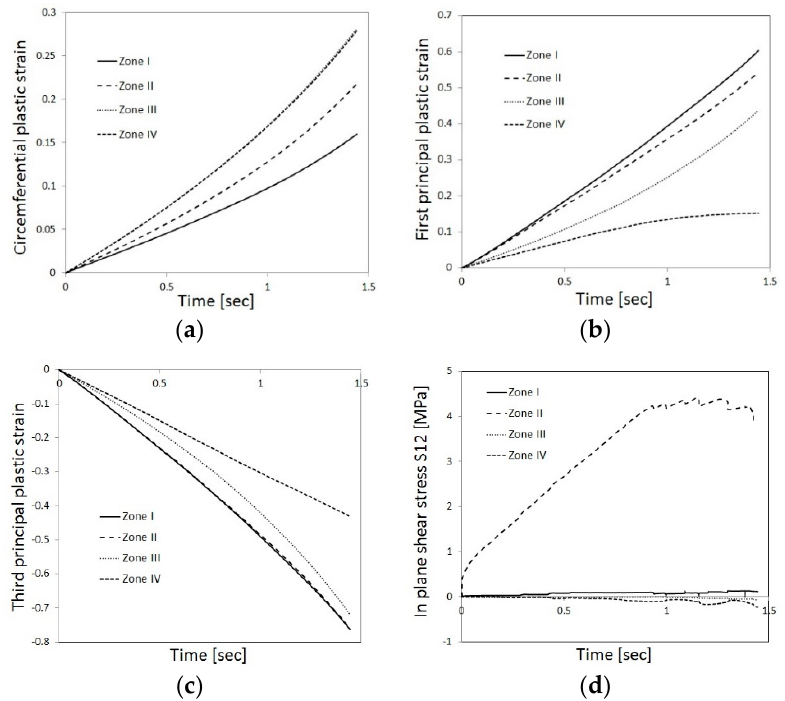
Figure 18. Average values of thermo-mechanical fields within specimen R13 at each zone: out-of-plane (circumferential) principal strain ( a ), maximum in-plane ( b ), and minimum in-plane ( c ) principal strains, and the shear stress ( d ) evolution with time.